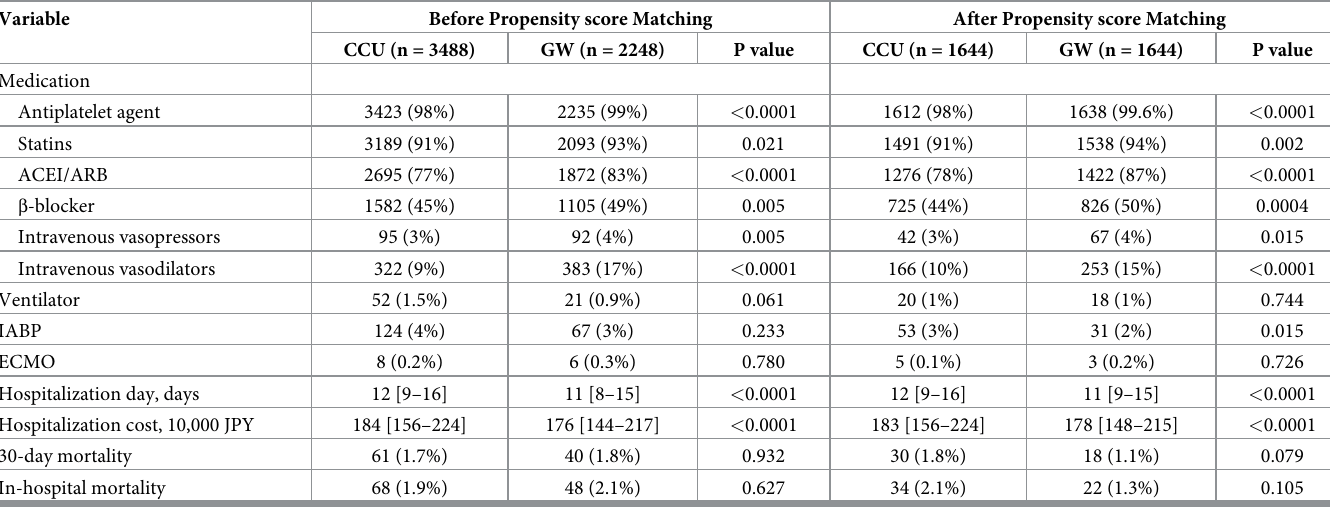
Table 2. Post treatment variables and outcomes (before and after propensity score-matched cohort).